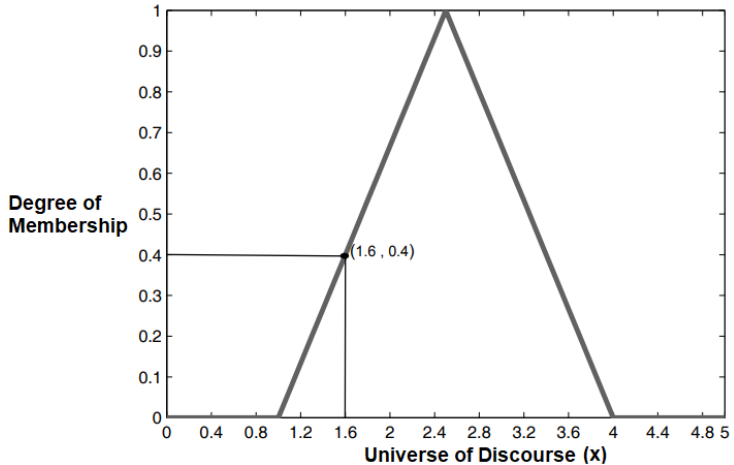
Figure 13. Example of degree of membership.